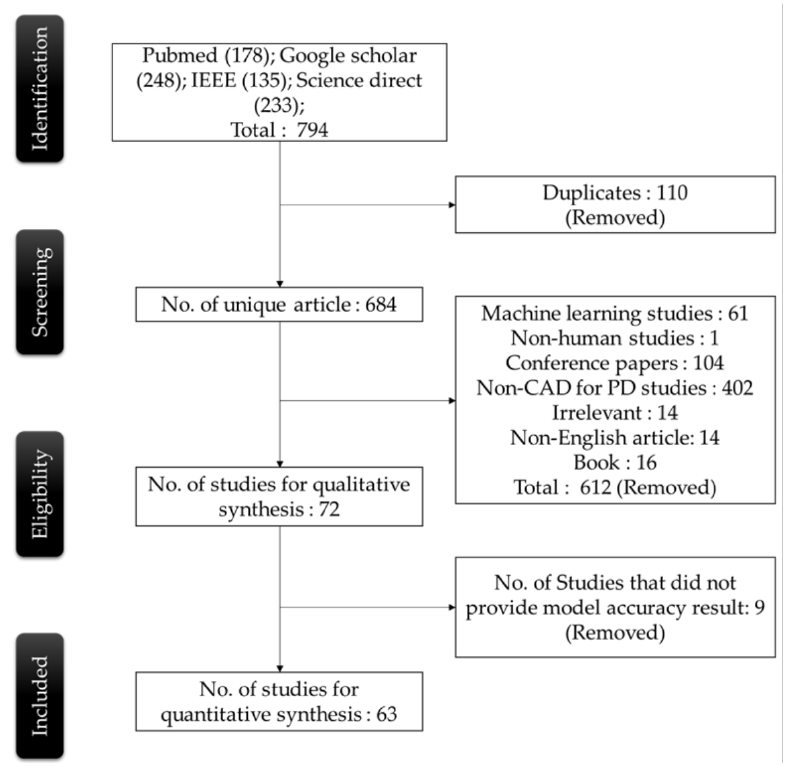
Figure 4. Flow diagram of the PRISMA model in the article selection process to build the systematic